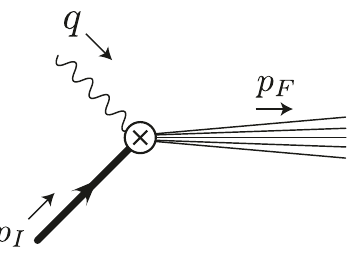
Figure 1 . Deep inelastic scattering